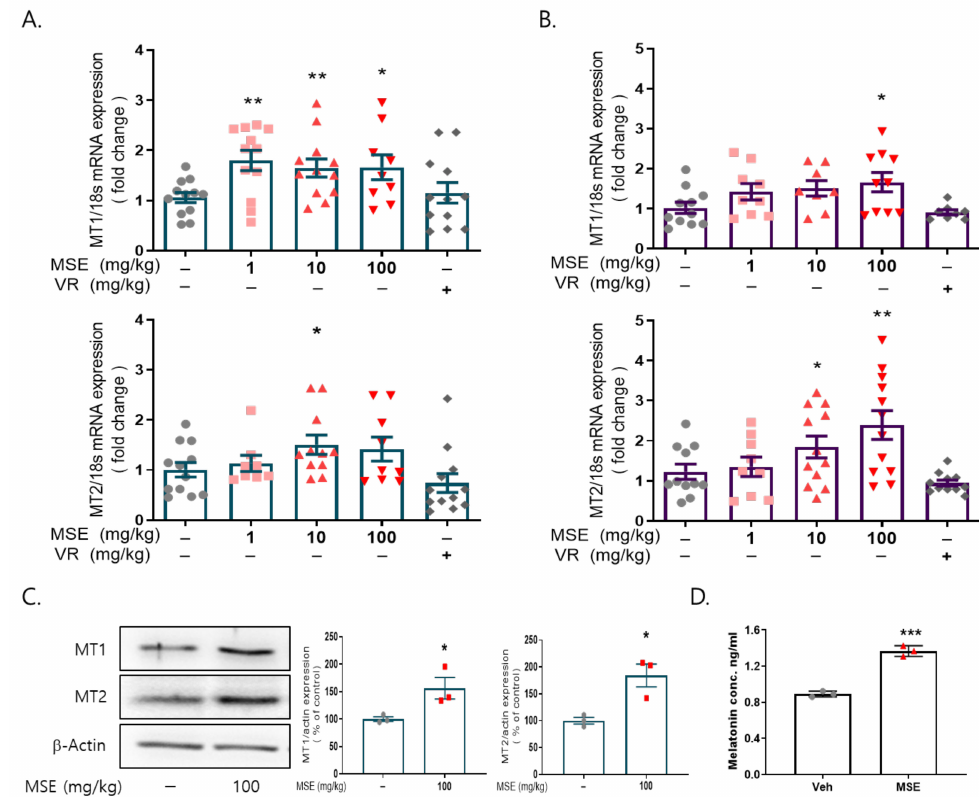
Figure 3. Effects of Maydis stigma extracts on the expression of melatonin receptors 1 and 2 in the brain. Mice were administered MSE (1, 10, 100 mg/kg) and positive control (valerian root extract; VR, 10 mg/kg) for 7 days. After sleeping test, blood from the mice was collected, and the brain was dissected. ( A ) mRNA expression of MT1 and MT2 in the hypothalamus, ( B ) mRNA expression of MT1 and MT2 in the frontal cortex. * p < 0.05, ** p < 0.01; Veh vs. MSE (N = 8–12). ( C ) Protein expression of MT1 and MT2 in the frontal cortex. ( D ) Melatonin levels from plasma. * p < 0.05, ** p < 0.01, *** p < 0.001; Veh vs. MSE (N = 3).